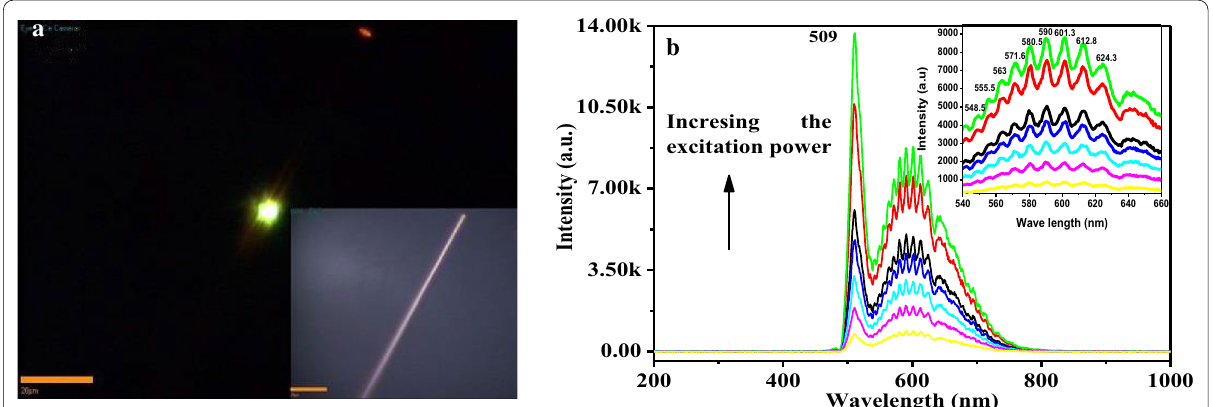
Fig. 4 a Far-field emission image of single Sn-doped CdS nanowire. Inset is the bright-field optical image of corresponding single nanowire. Scale bars are 20 μm. b Far-field PL spectra under increasing excitation power. Inset is the local scale-up of impurities emission